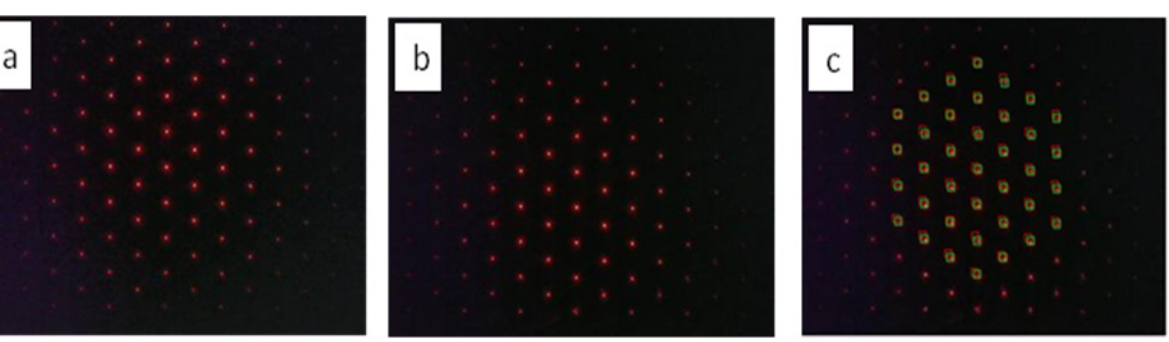
Figure 9. (a) Focal spots image of the reference wavefront, (b) focal spots image of the aberrated wavefront, and (c) detection picture of image spots for reference beam and distorted